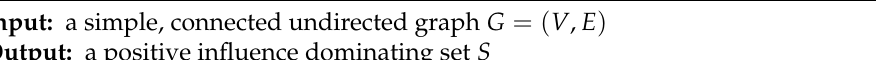
Algorithm 2 Pan’s greedy algorithm